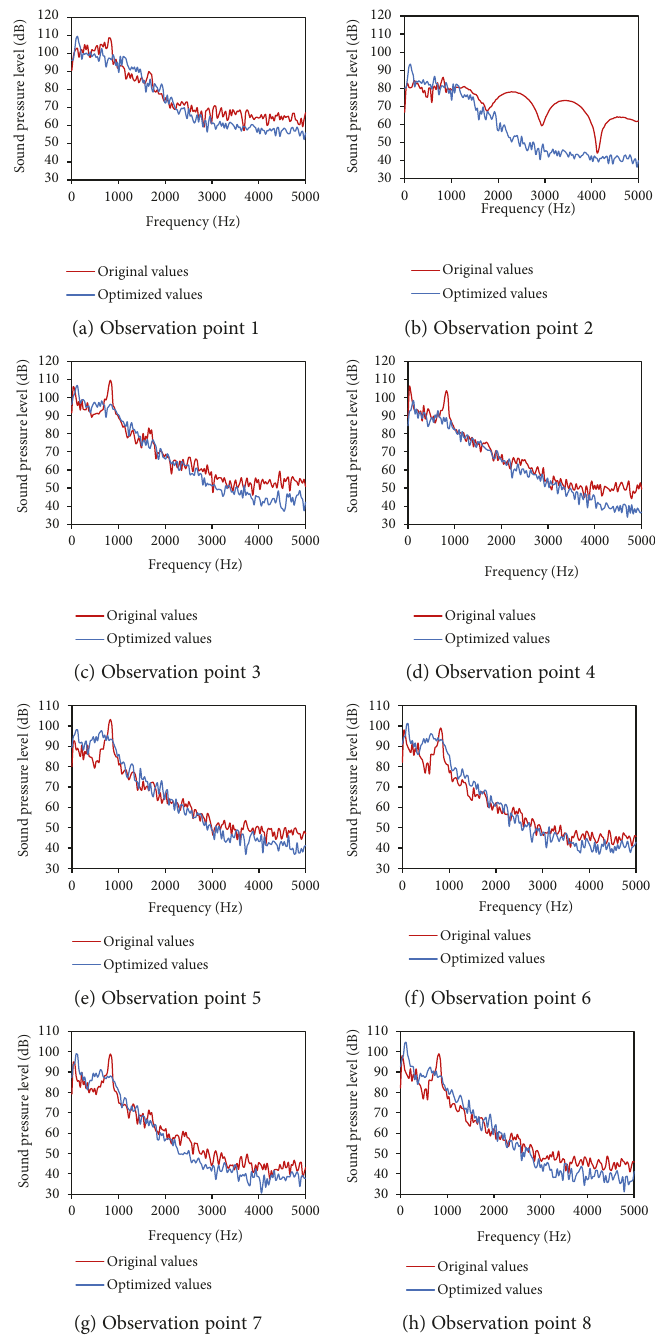
Figure 10: Comparison of sound pressure levels of observation points before and after